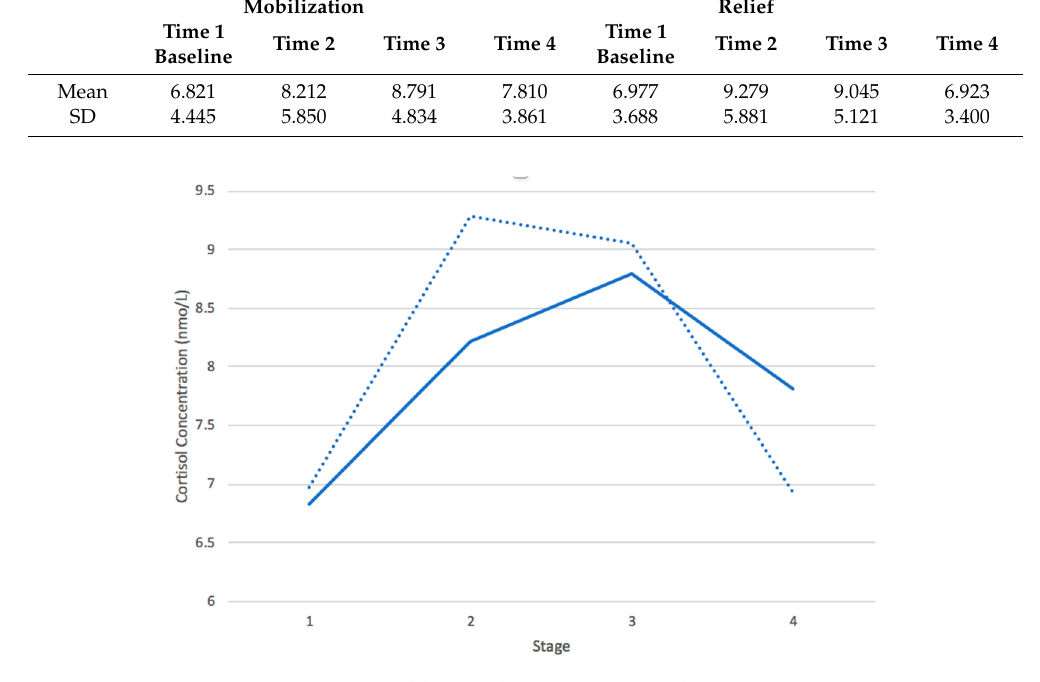
Figure 2. The relationship between baseline salivary cortisol concentrations and attachment avoidance for high and low attachment anxiety. Table 1. Descriptive Statistics of Cortisol Concentrations (nmo / L) Under Four Blocks in Two Conditions. Mobilization